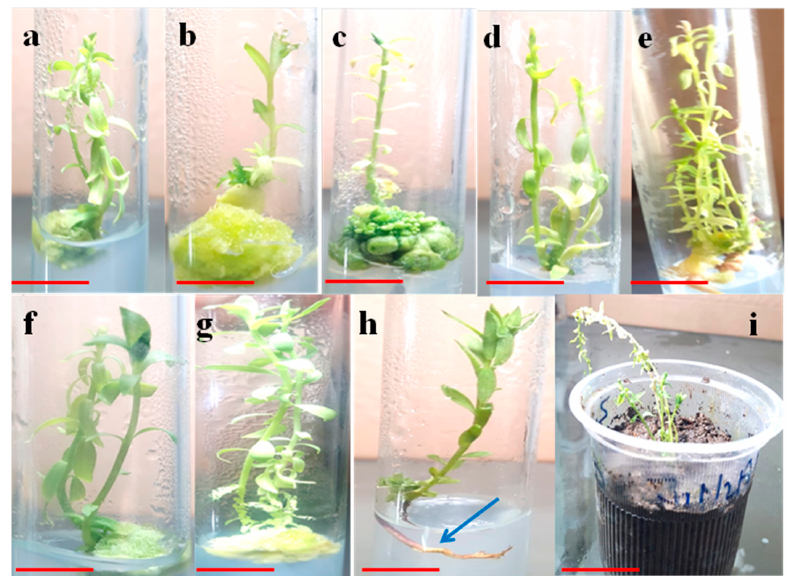
Figure 1. Invitro micropropagation in L. usitatissimum, ( a ): shoot regeneration in hypocotyl explants in response to 0.5 mg/L TDZ, ( b ): shoot regeneration in hypocotyl explants in response to 1.0 mg/L TDZ, ( c ): shoot regeneration in hypocotyl explants in response to 1.5 mg/L TDZ, ( d ): shoot regeneration in hypocotyl explants in response to 0.5 mg/L Kn, ( e ): shoot regeneration in hypocotyl explants in response to 0.5 mg/L TDZ + 0.5 mg/L Kn, ( f ): shoot regeneration in hypocotyl explants in response to 1.0 mg/L TDZ + 0.5 mg/L Kn, ( g ): shoot regeneration in hypocotyl explants in response to 1.5 mg/L TDZ + 0.5 mg/L Kn, ( h ): rooting of the micropropagated shoots in presence of 0.1 mg/L IBA at half strength MS media, arrow indicates the development of roots at the base of shoots, and ( i ): hardening and acclimatization of the micropropagated plants, Bar 2.0